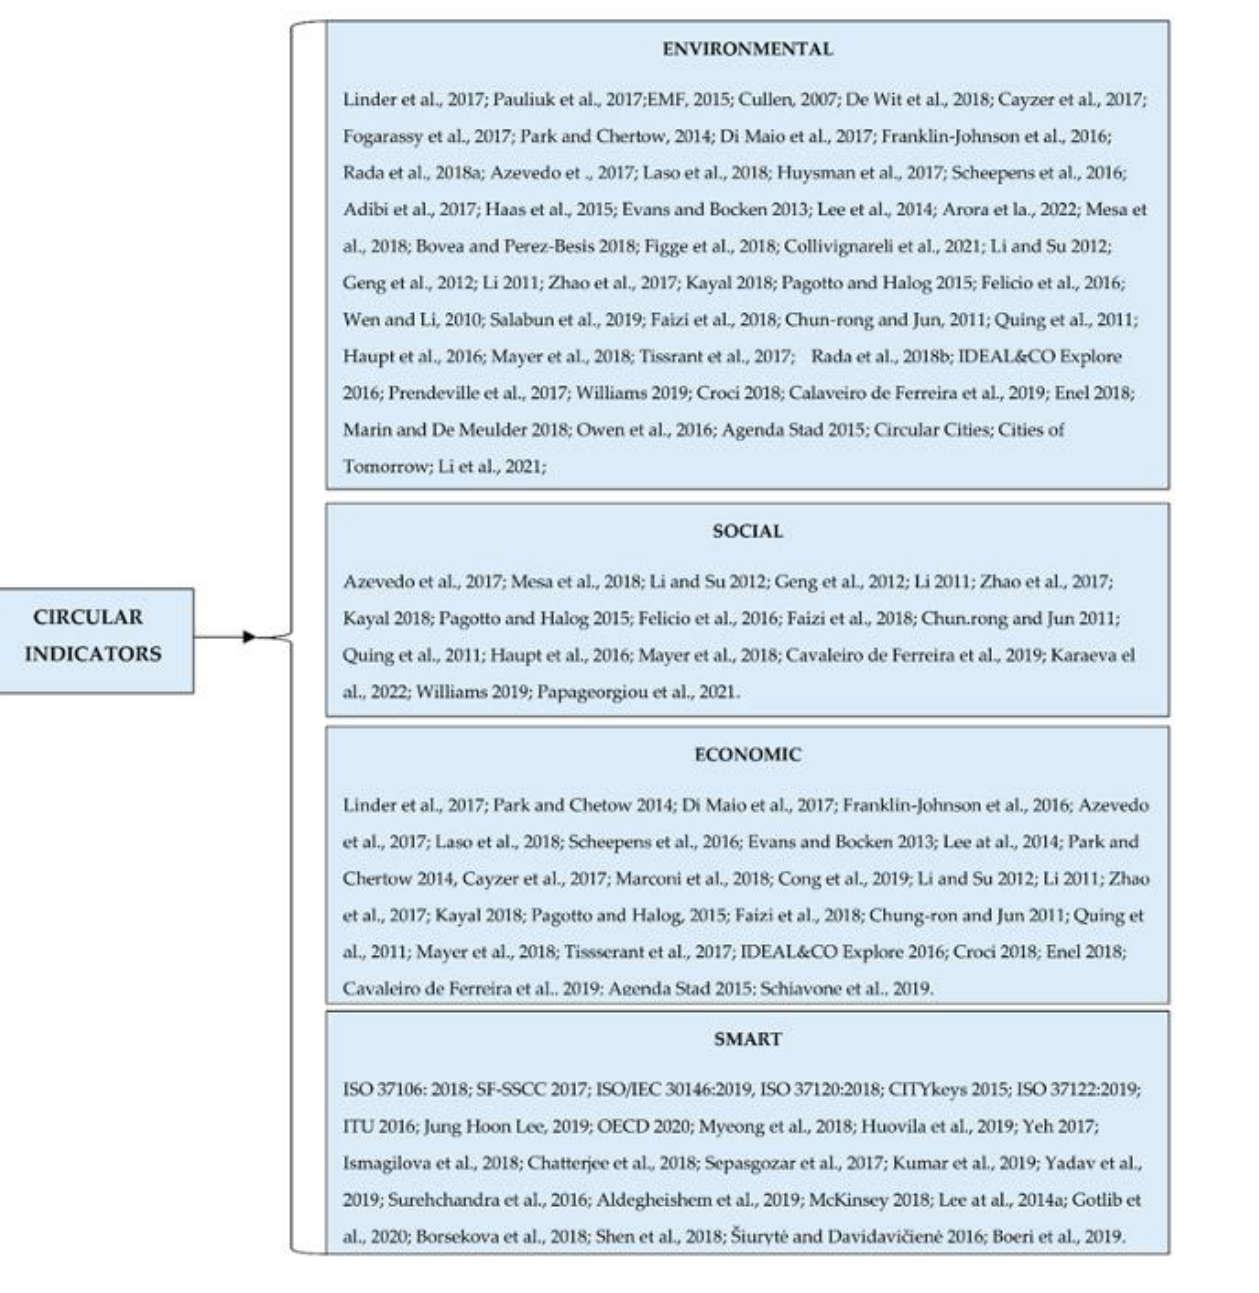
Figure 3. The reviewed studies on circular cities indicators [58 – 136].